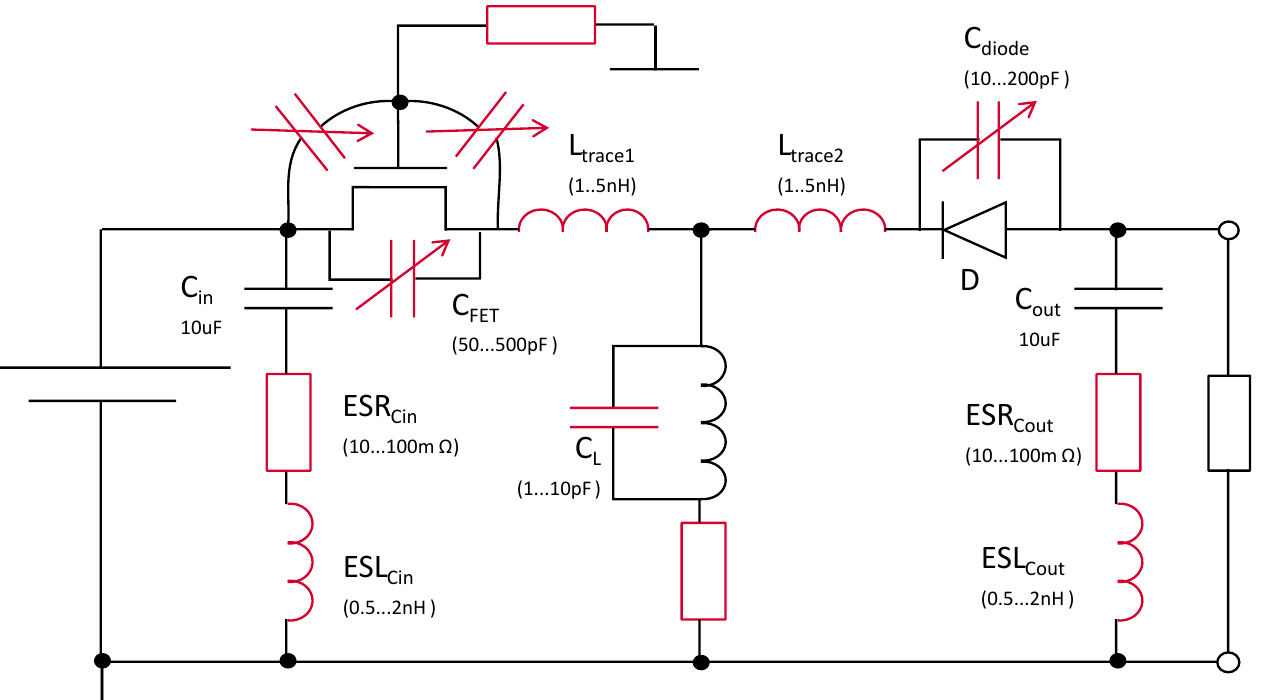
Figure 2. Circuit including parasitic components.